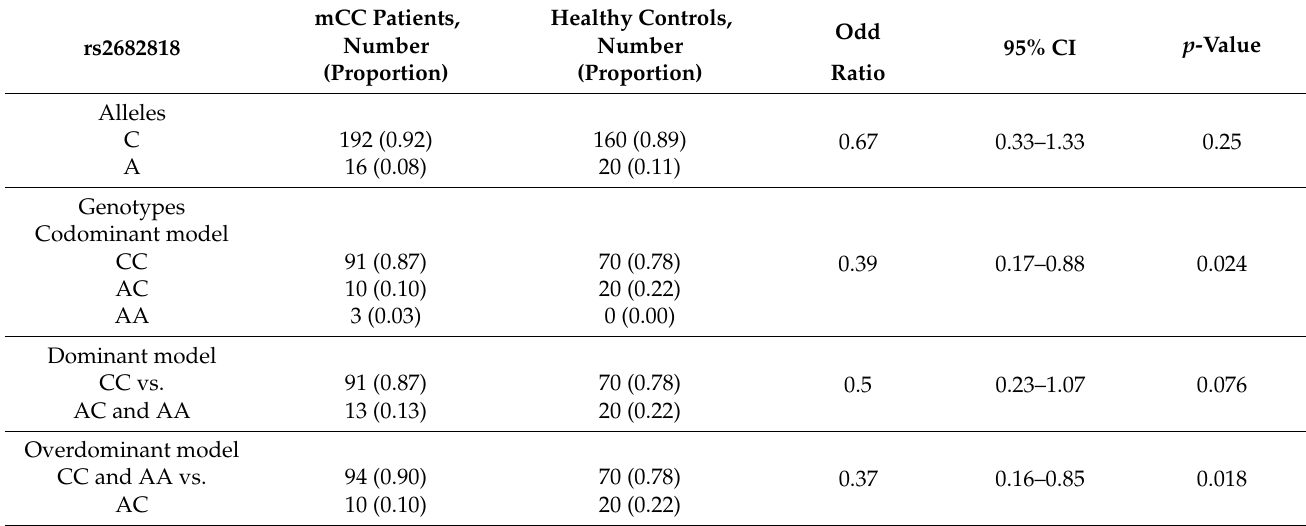
Table 3. Genotypes distribution and allele frequencies of rs2682818 in mCC patients ( n = 104) and healthy controls ( n = 90). Association of rs2682818 SNP with colon